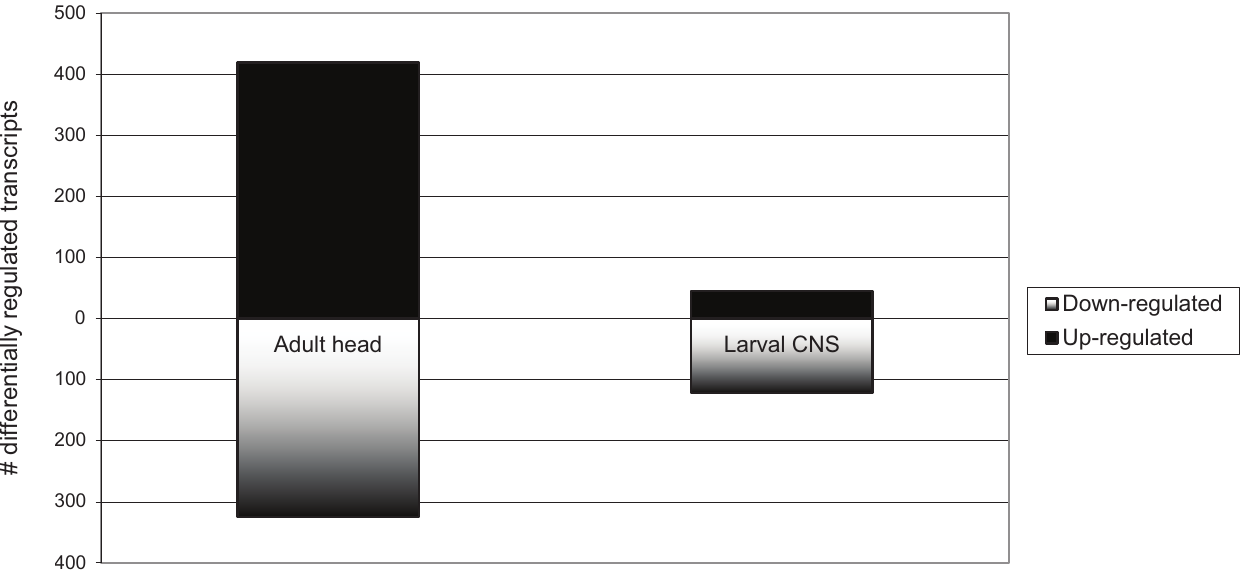
Figure 2. Global patterns of gene expression differences among sample groups: A ) Hierarchicalclustering: Neighbor joining tree based on pairwise distance matrices (1 2 r , Spearman correlation coefficient) for the different sample groups within this study. Sample groups fall out based on the strongest factor, larval CNS or adult head, respectively, i.e. developmental stage. Thereafter on either Btk29A ficP (red) or revertant ( Btk29A (fic Exc1–16) ) (green). B ) Factorialmapoftheprincipal-componentanalysis: The replicates within each sample collection are grouped together based on the individual samples whole genome expression profile. Revertant is denoted with D and ficP with a o. All samples are colored individually. The proportion of the variance explained by the principal components (axis) is indicated in parentheses in the graph. C ) Samplecorrelationmatrix: Spearman correlation (R 2 ) is calculated and visualized by color (red-blue) in the matrix. Within the replicates for the individual sample groups the correlation is higher than between the sample groups. Also, the correlation within developmental stage was found to be higher compared to between mutant strains. Sample names are color-coded with red ( Btk29A ficP ) and green (revertant).